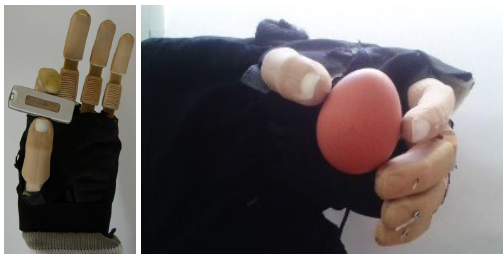
Figure 3. ISR- Softhand performing a tip pinch grasp and a tripod grasp.